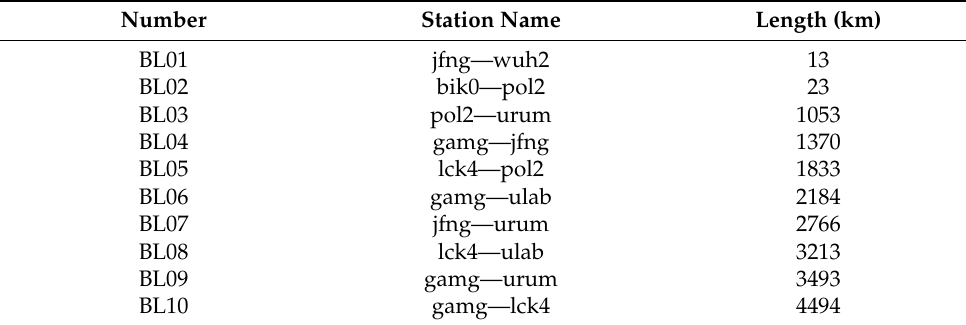
Table 2. PPP processing strategy.